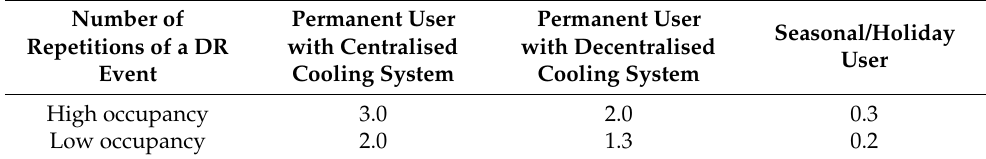
Table 6. Daily repetitions of a DR event—cooling.